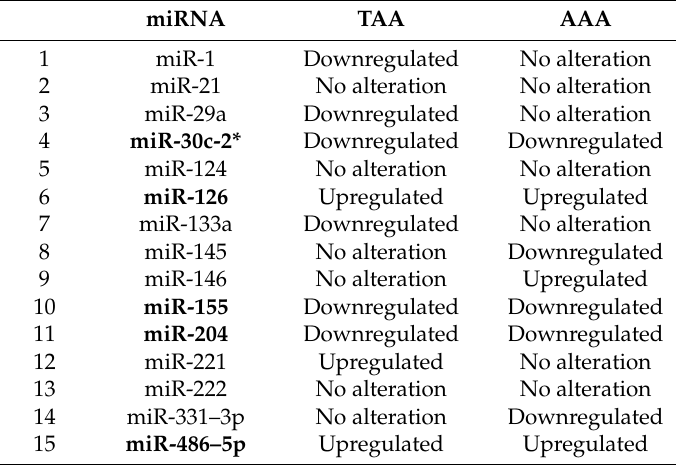
Instances where miR-126 and miR-486–5p were upregulated in both TAA and AAA are indicated in bold font. Similarly, instances where miR-30c-2*, miR-155, and miR-204 were downregulated in both TAA and AAA are indicated in bold font.